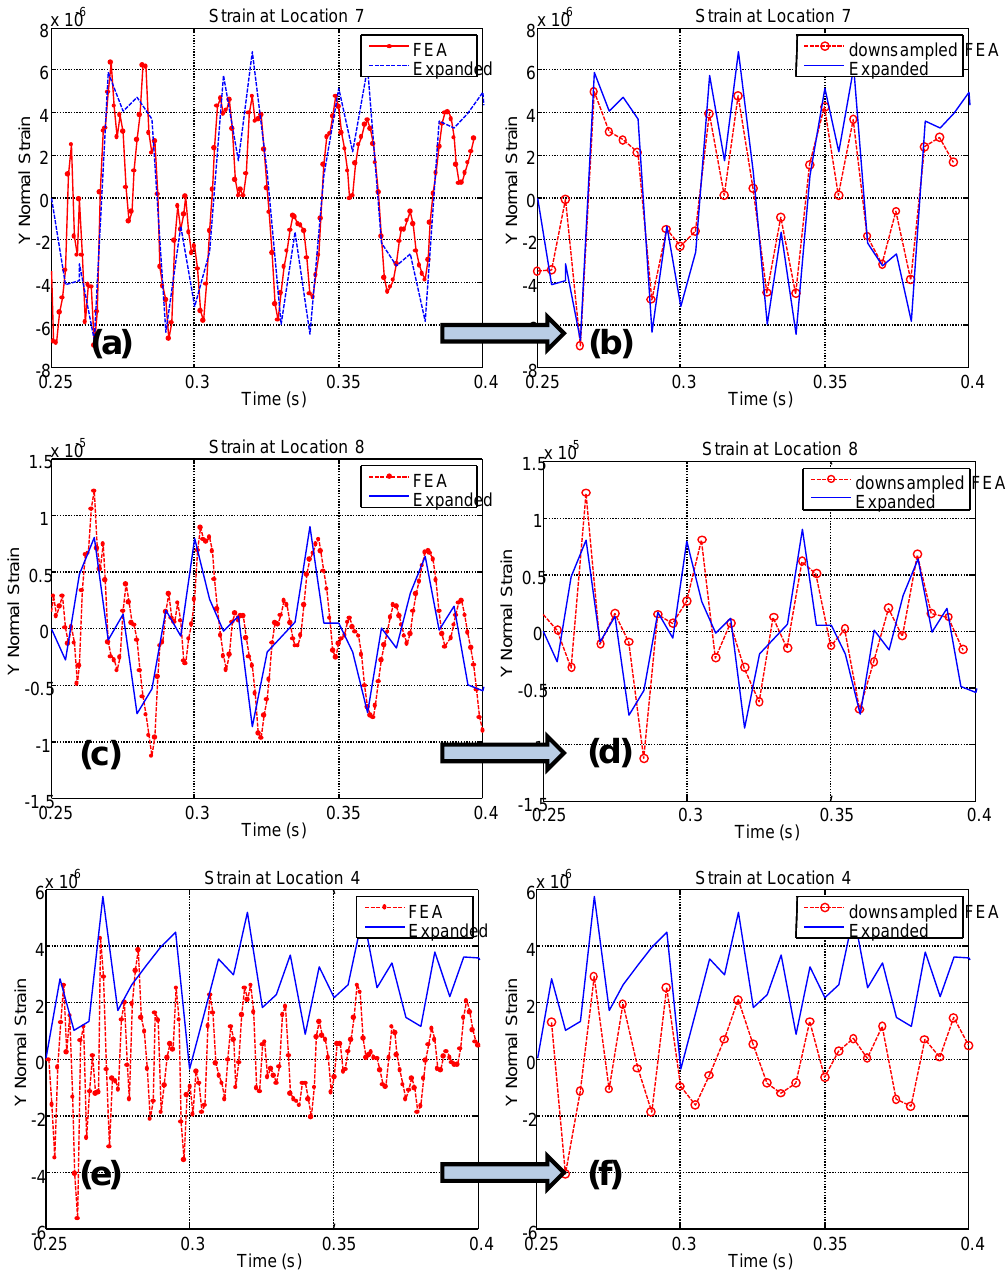
Fig. 16. Comparison of strain response from FEA solution and predicted solution using direct integration of the equations of motion with (a,c,e) contain finer step and (b,d,f) contain identical time Figs 16a, c and e at locations 7, 8 and 4 respectively in the BU. The response shown is after the impact was made at 0.25 seconds for a sample time period of 0.15 seconds. The FEA transient solution was obtained for 400 steps with 0.001 seconds per step. The strain solution obtained from the proposed technique uses the full-field displacement solution. So the displacement sampling rate of 0.005 sec per sample also applies for the strain obtained from